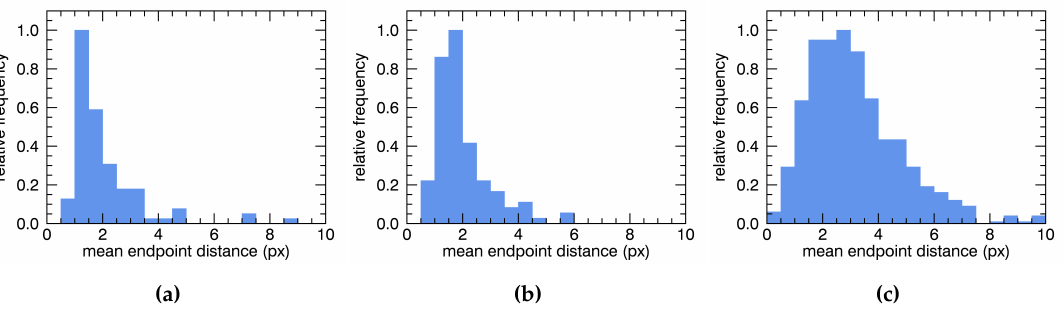
Figure 9. Distribution of mean endpoint distances. ( a ) R 0 : N = 129, σ = 1.75 px; ( b ) R + σ = 1.25 px; ( c ) R 10 : N = 1411, σ = 2.75